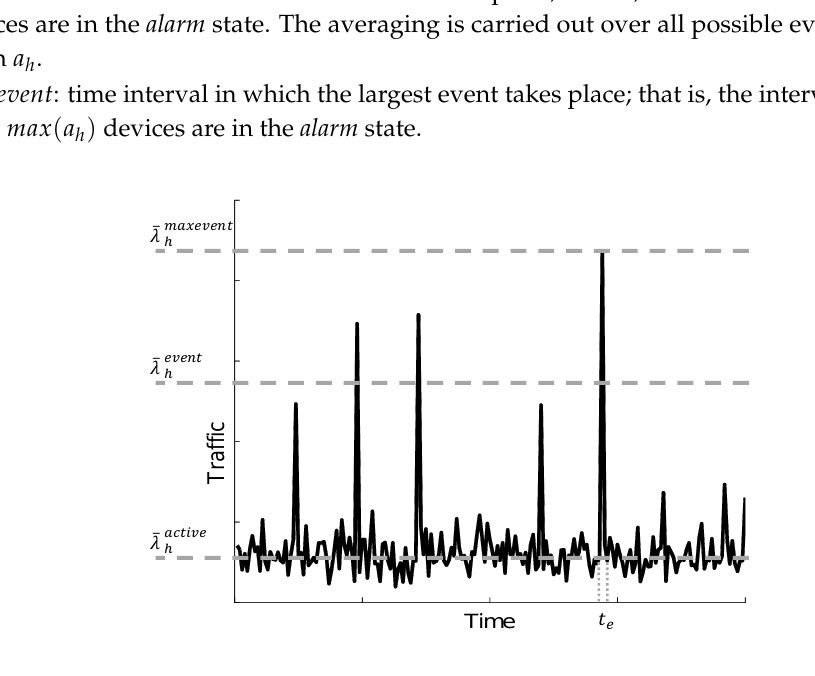
Figure 5. Parameters for the M2M traffic